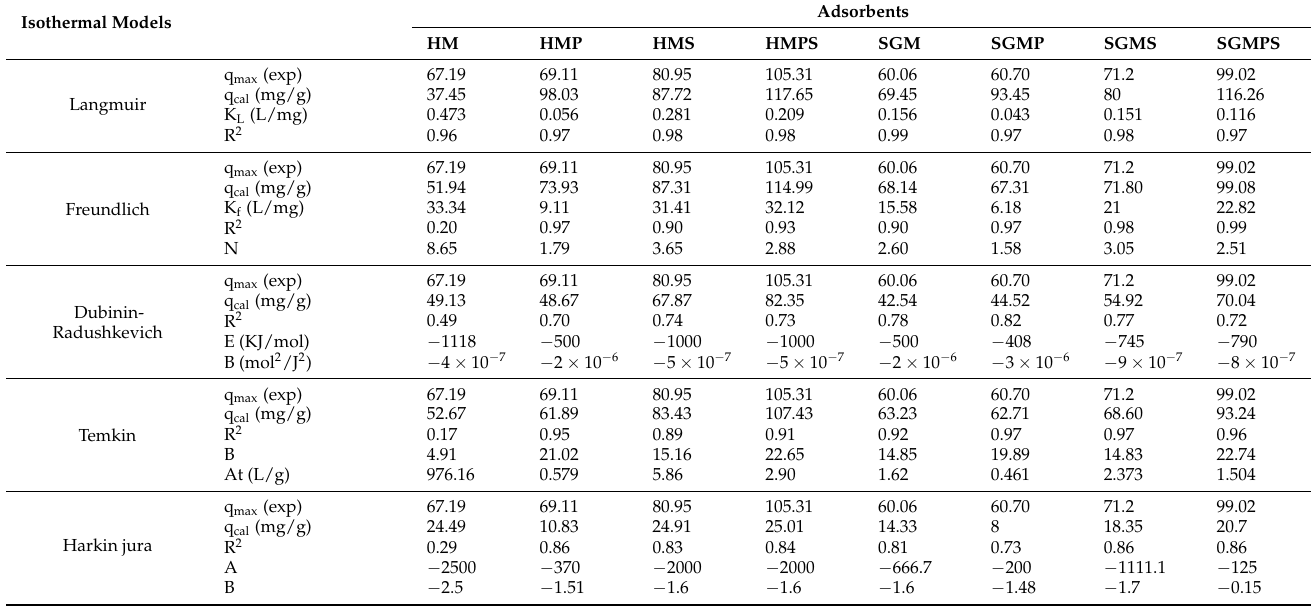
Table 1. A comparison of Langmuir isotherm, Freundlich isotherm, Temkin, Harkin jura, Dubinin– Radushkevich isotherms for predicting involved process direct violet 51 dye adsorption data using hoshanar and sunny grey marble waste